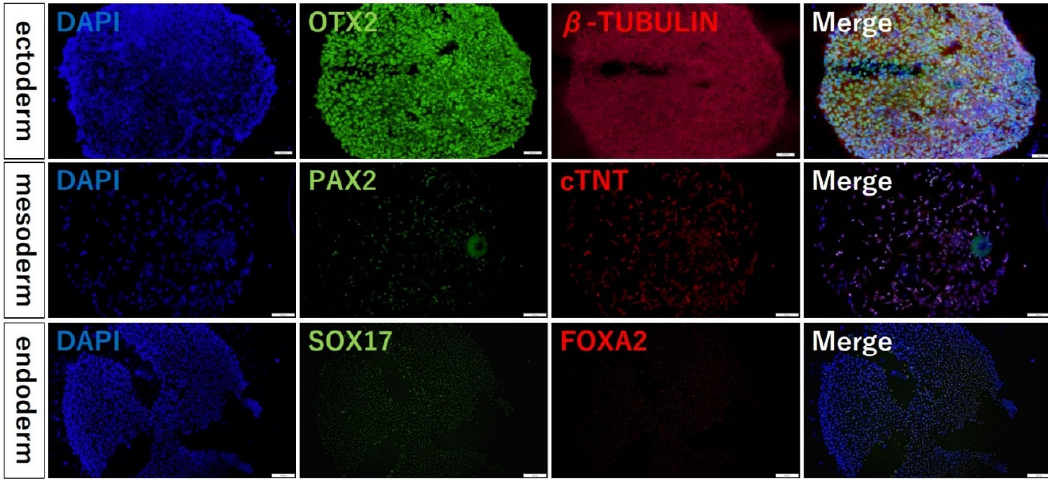
Figure 6. Fluorescent immunostaining results of the multidifferentiation abilities. Blue coloration shows where the cells localize, and they emit green or red (FOXA2, SOX17, PAX2, cardiac Tro ‐ ponin T, OTX2, OCT4, β tubulin) depending on the localization of each protein.